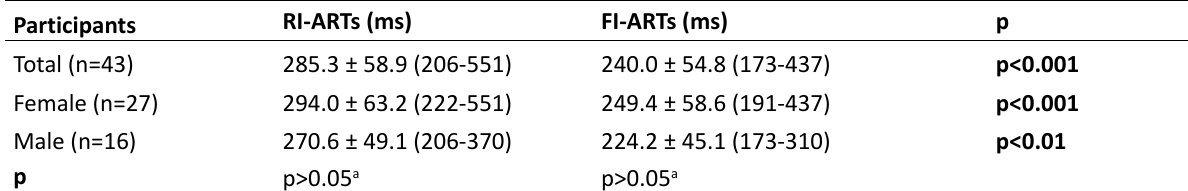
Table 3. Comparison of random interval auditory reaction times (RI-ARTs) and fixed interval auditory reaction times